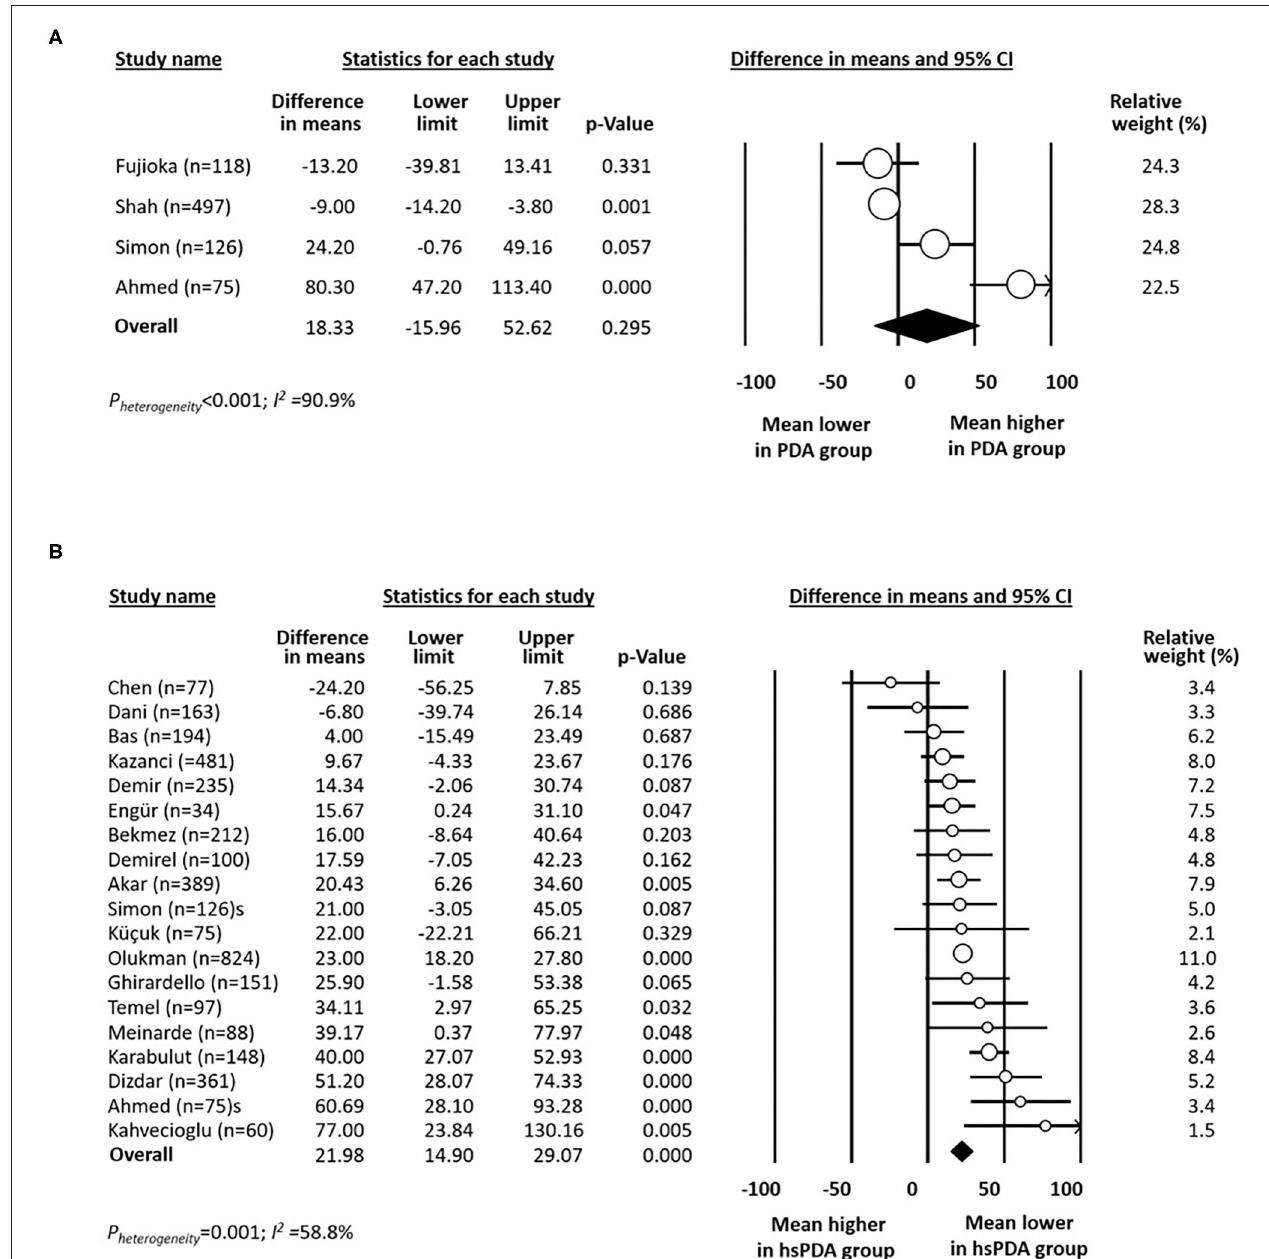
FIGURE 2 | Forest plot for studies examining the difference (PDA-no minus PDA-yes) in mean platelet count ( × 10 9 /L) in the first day(s) of life in infants with and without any patent ductus arteriosus (PDA, A ) and with and without hemodynamically significant patent ductus arteriosus (hsPDA, B ).